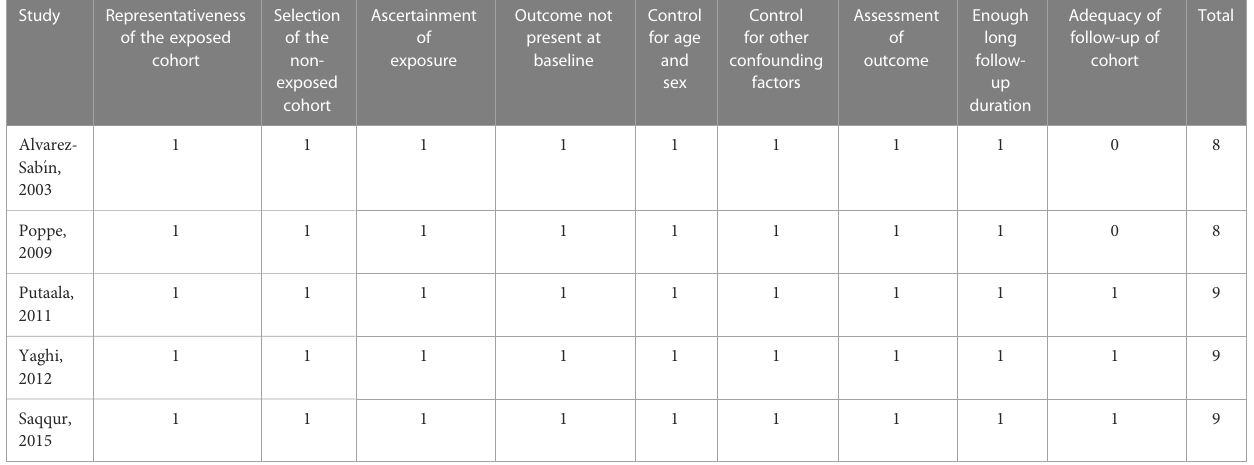
TABLE 2 Quality evaluation of the included cohort studies via the NOS. Study